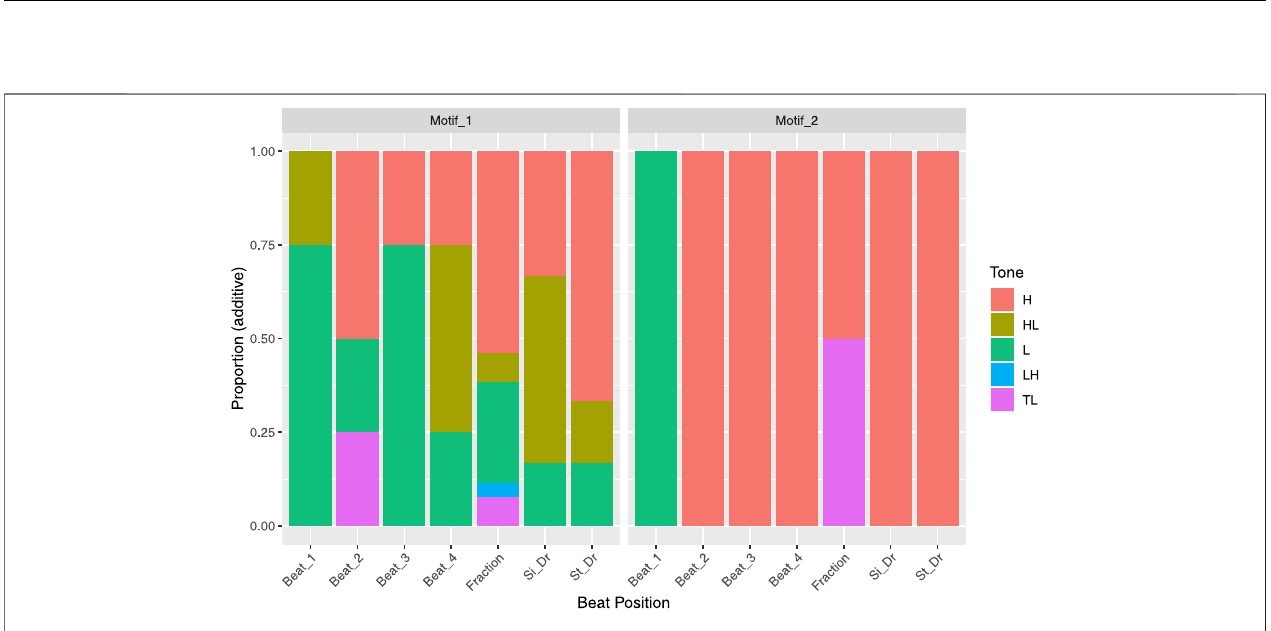
FIGURE 15 | Alignment of syllables by tone and motif in master drummer ’ s verses of Song 2 represented as proportions of occurrences.